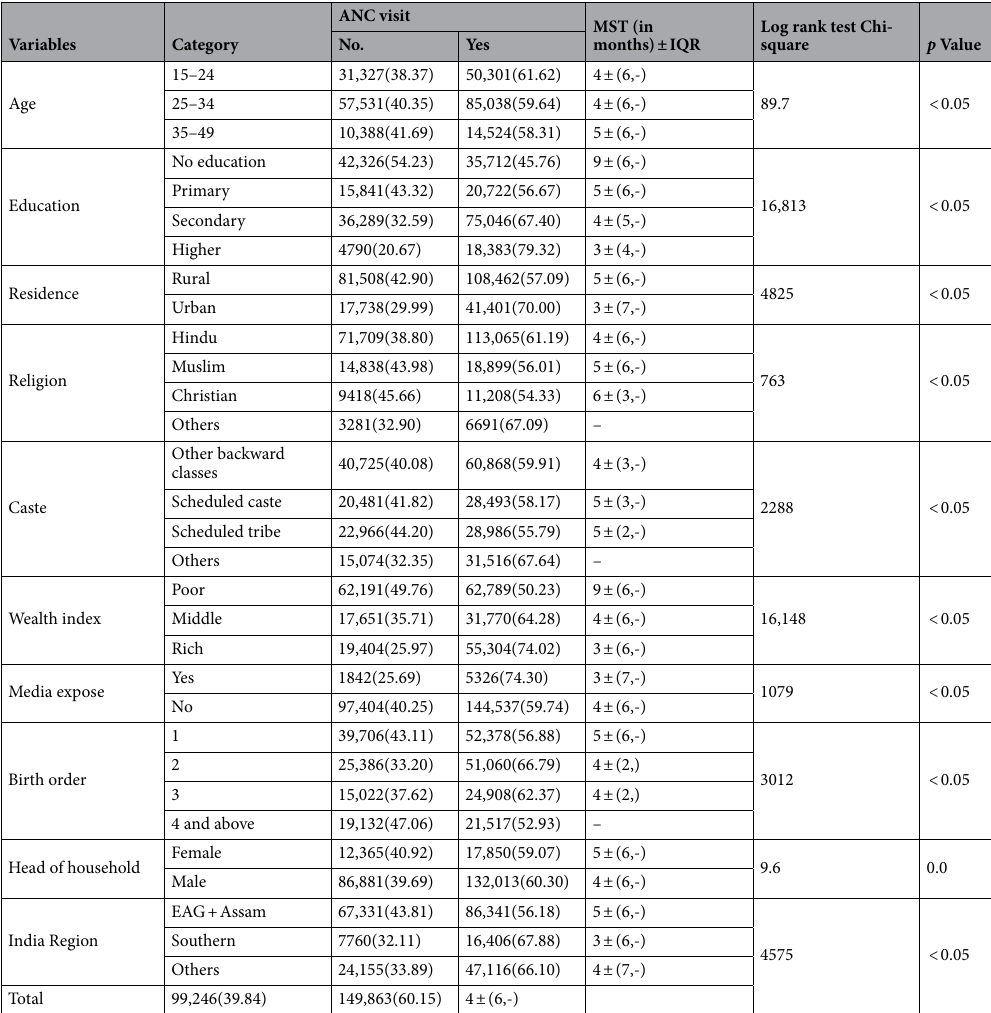
Table 2. Proportion of study participants by background characteristics, ANC utilization, Median Survival Time, and log-rank test for timing of first ANC from NFHS-4 (2015–2016). ( Source: NFHS-4, 2015–2016 ). IQR: Inter-quartile range, EAG: empowered action group, Others region: this includes-northeastern states except- Assam, Union territories, and small states of